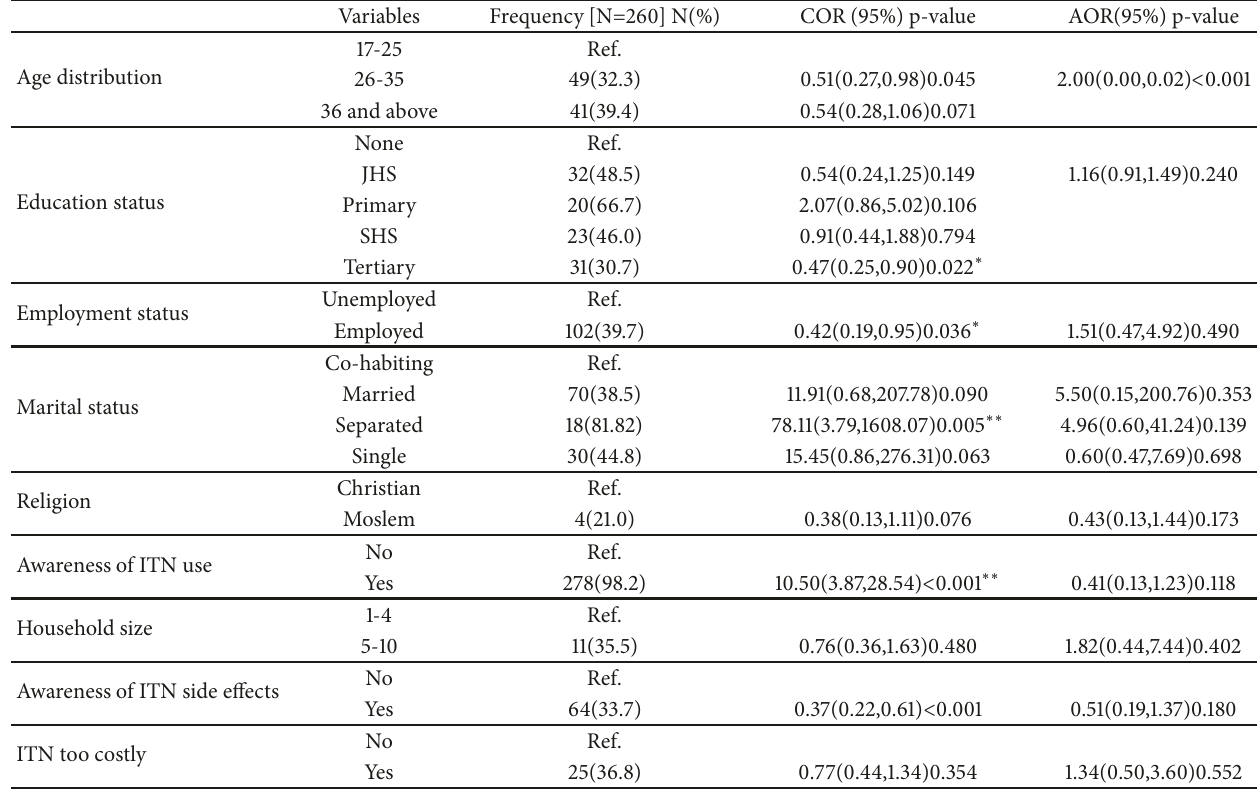
Table 2: Factors associated with ITN